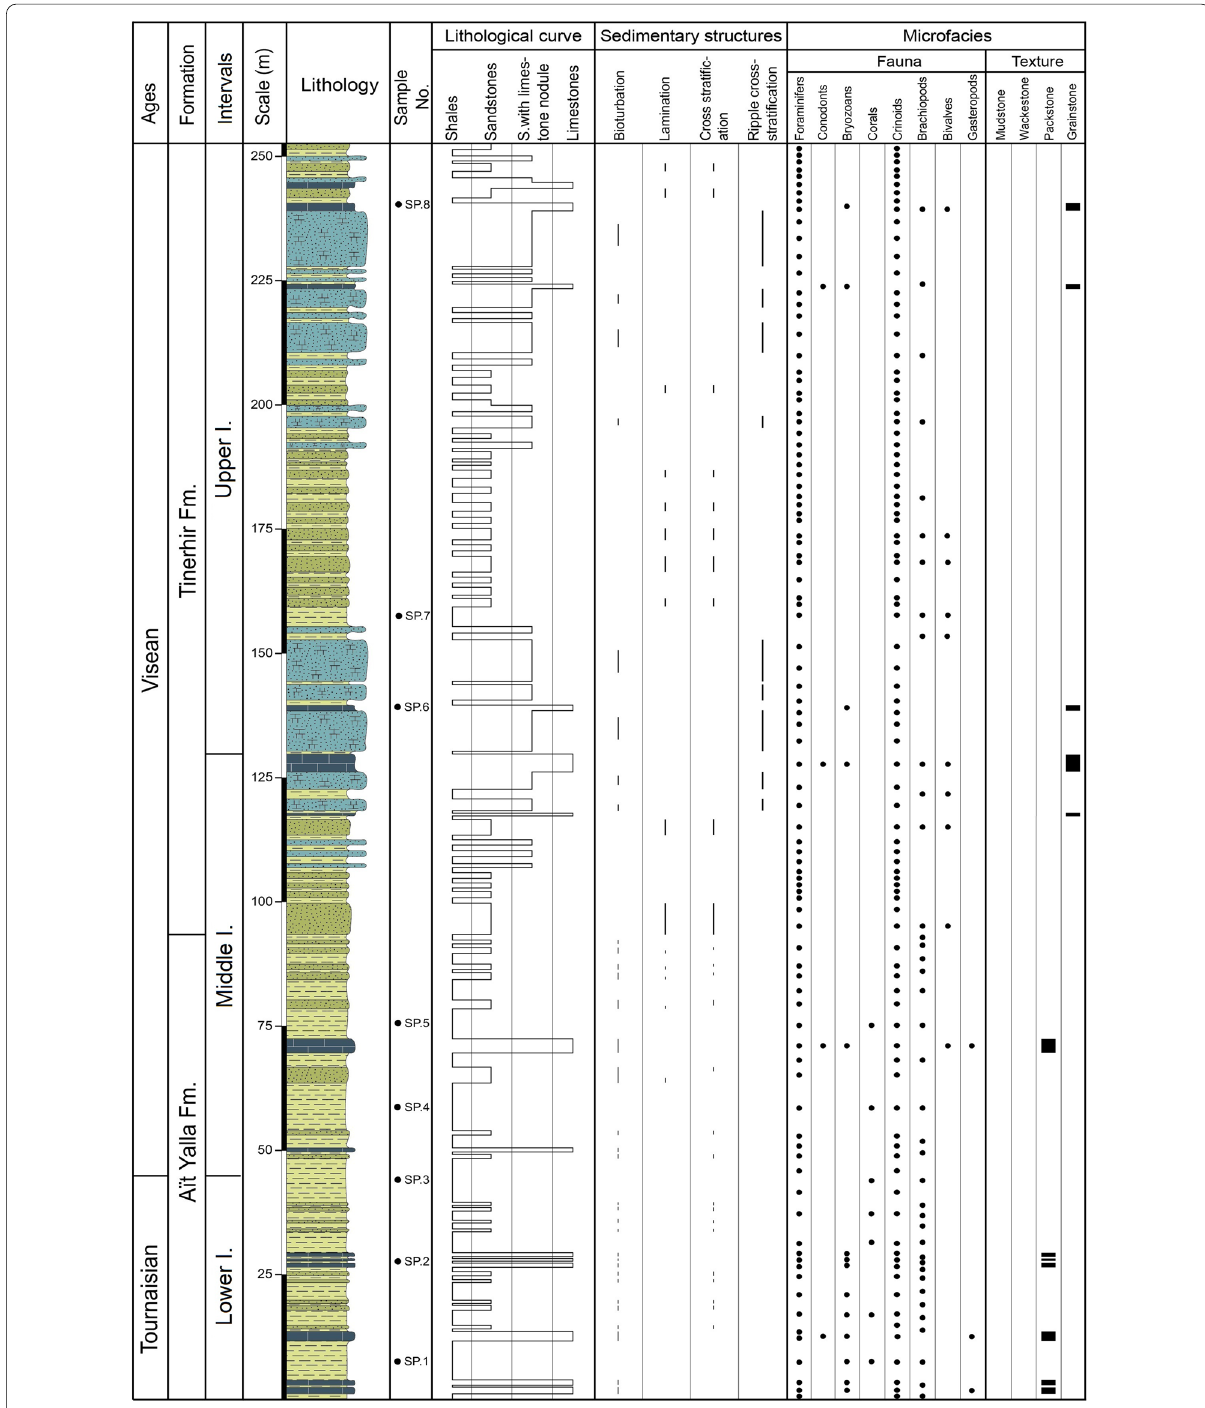
Fig. 3 Lithostratigraphic and sedimentologic analyses of the Mississippian succession of the Jbel Asdaf area, showing the lithology, position of palynological samples (SP numbers), sedimentary structures, and microfacies, including fauna and general texture of thin